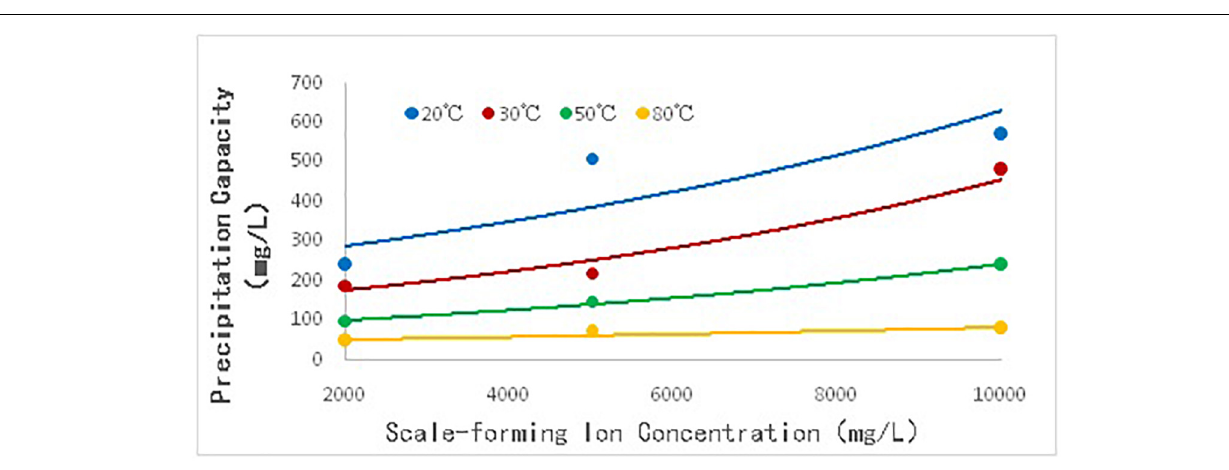
FIGURE 4 | The relationship between pressure difference and precipitation capacity.